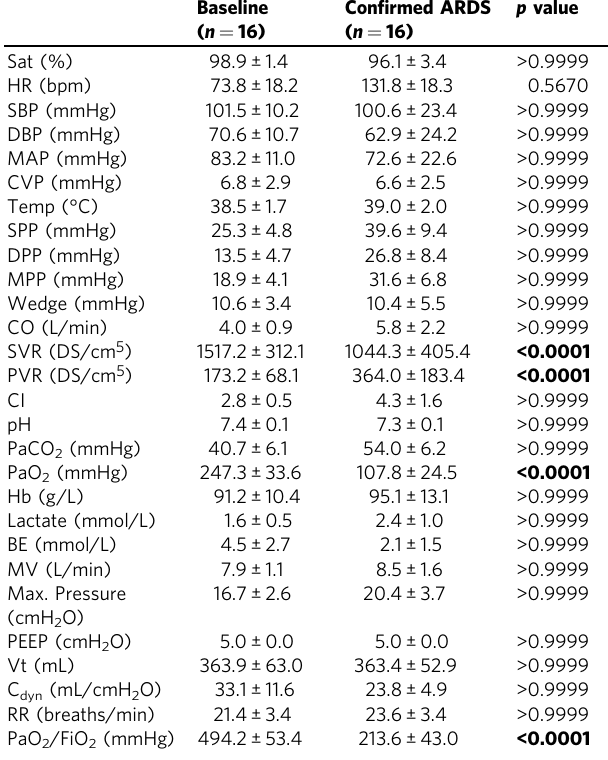
Table 1 Clinically relevant measurements of vitals and mechanical ventilator settings during establishment of LPS- induced ARDS for all